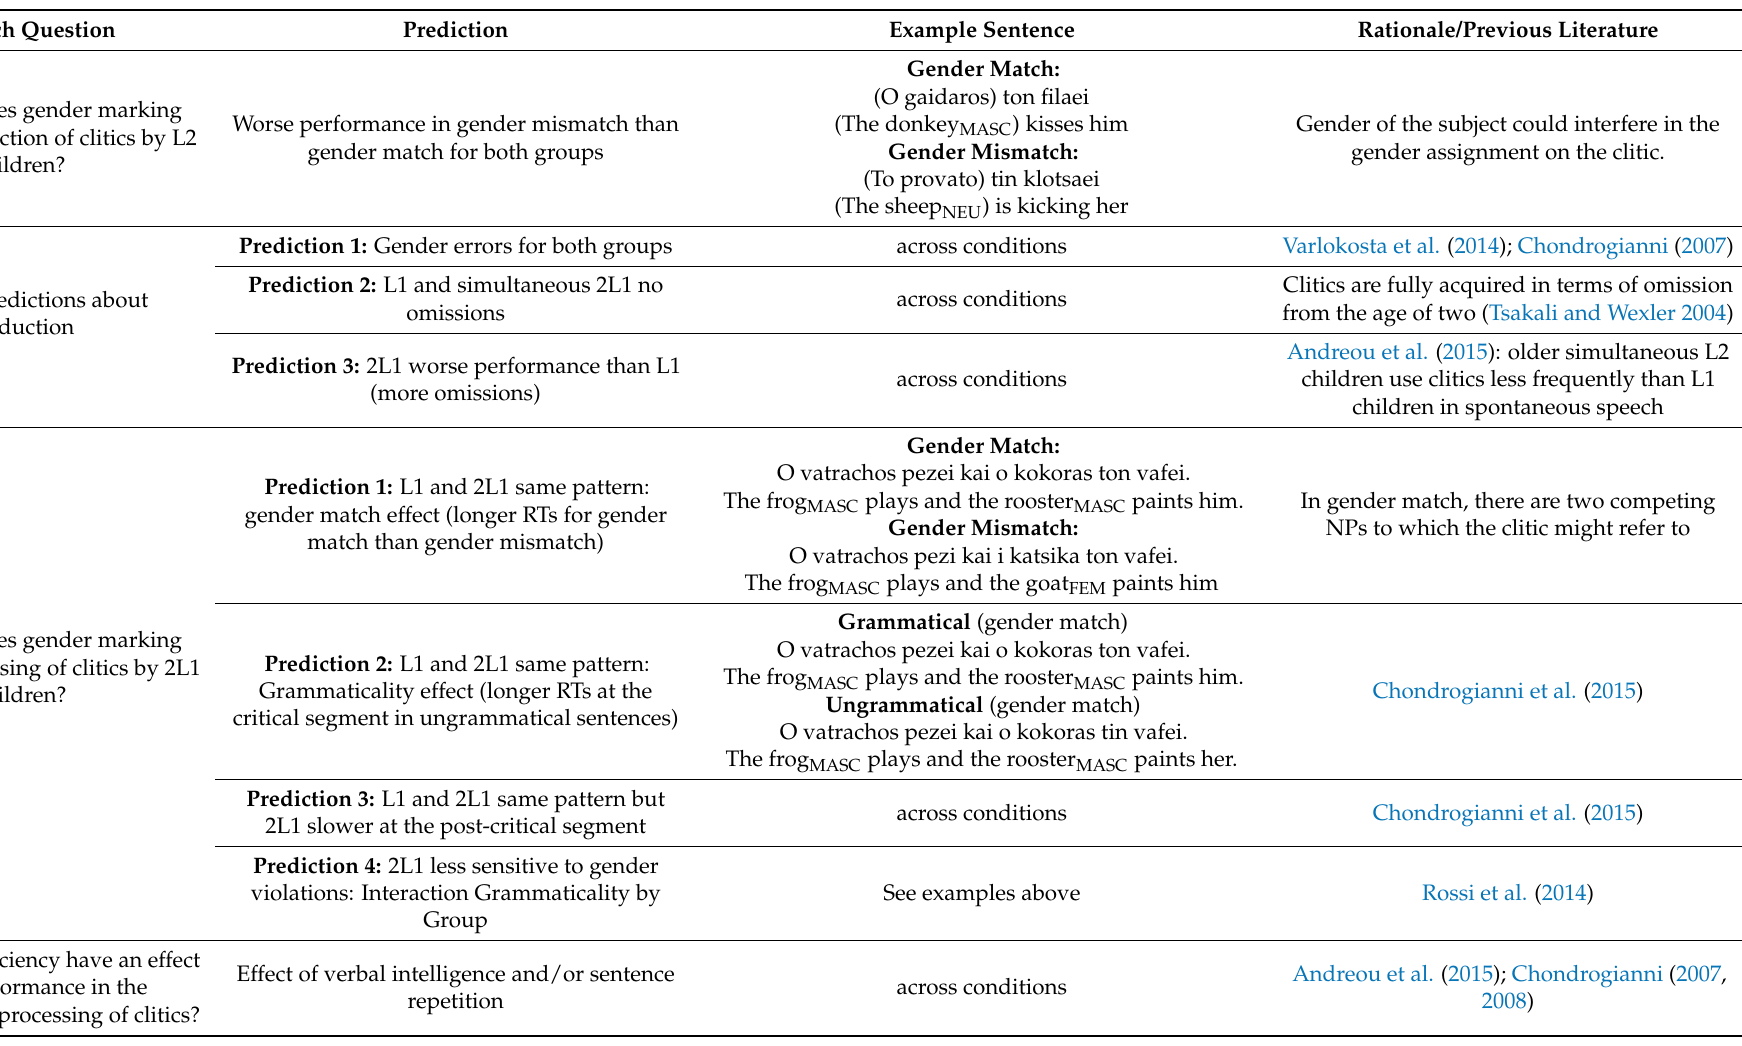
Table 3. Research questions, predictions, example sentences (if the prediction concerns difference in the performance between conditions) and the rationale of each prediction. For detailed descriptions of the example sentences the reader is referred to Section